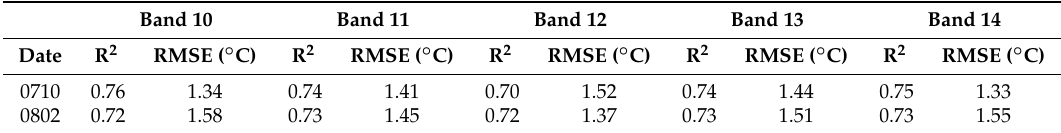
Figure 6. Observed ( a , b ) and simulated ( c , d ) surface BTs at 11.32 μ m on two days (10 July 2012 and 2 August 2012) and the corresponding scatterplots ( e , f ). The solid line represents the 1:1 line while the dotted lines represent the 1:1 line ± the RMSE. All of the BTs are given in °C. Table 2. Statistical information on the simulated BTs over the study area for each band.